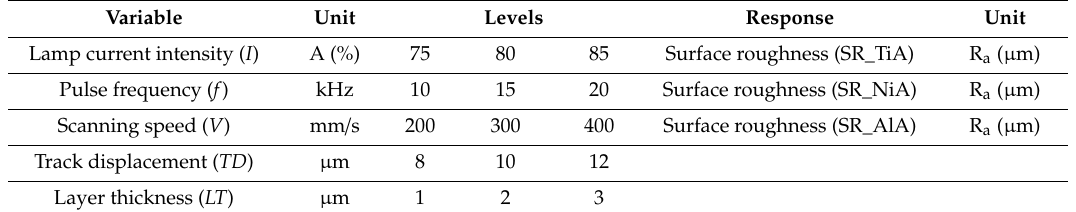
Table 2. Details of variables (symbols, units, levels) and